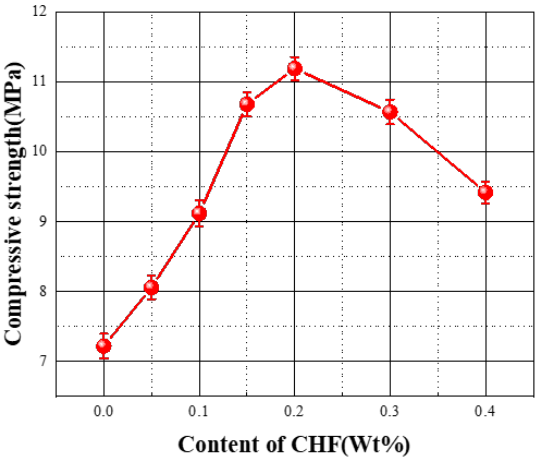
Figure 13. Influence of the content of CHF on the compressive strength of the material.